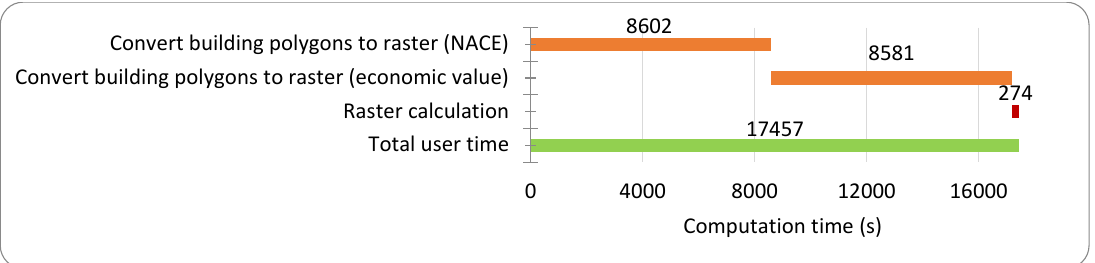
Figure 15. User time to calculate the economic damage of a coast flood event for the Belgian coast with a resolution of 5 m. Water 2019 , 10 , x FOR PEER REVIEW